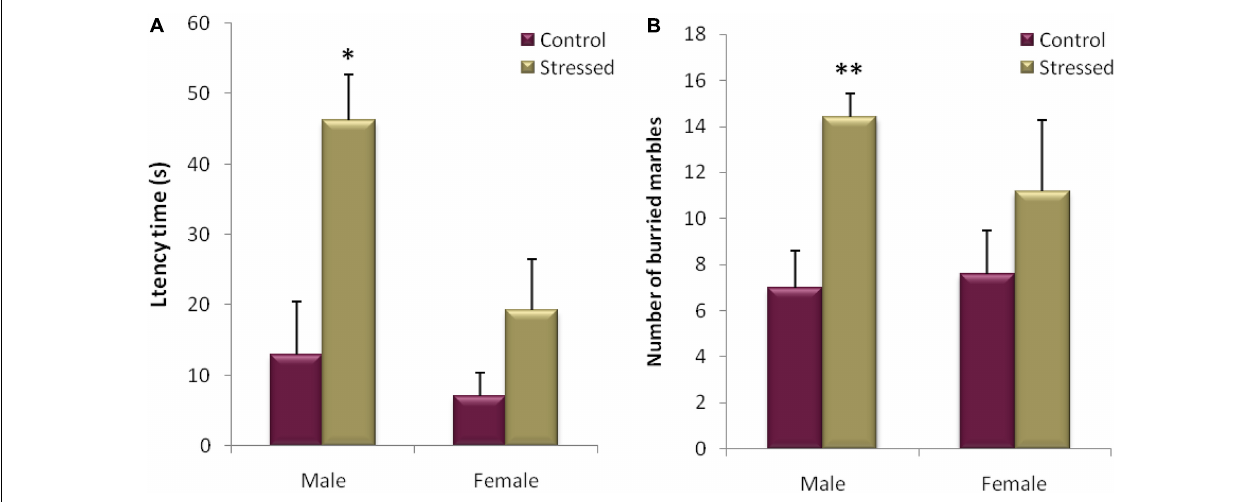
FIGURE 9 | Evaluation of the burying behavior in Marbel Burying test (MB) for 20 min of recording in male and female rats. The cold stress studied leads to an increase in the latency time (A) , as well as an increase in the number of buried marbles (B) in male rats. In female rats, exposure to cold had no detectable effect on latency time (A) and number of buried marbles (B) between the two groups of rats. Each histogram represents the mean ± SEM. Effect of stress: ∗ p < 0.05, ∗∗ p < 0.01, ns p > 0.05 ( n =